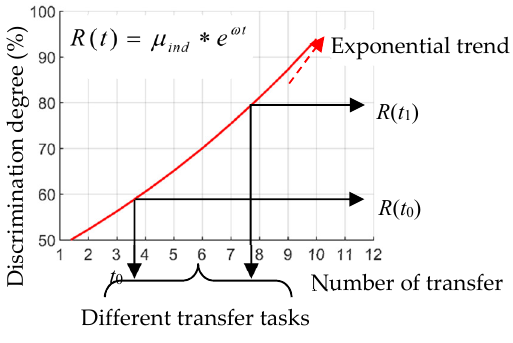
Figure 6. The mental fatigue model.